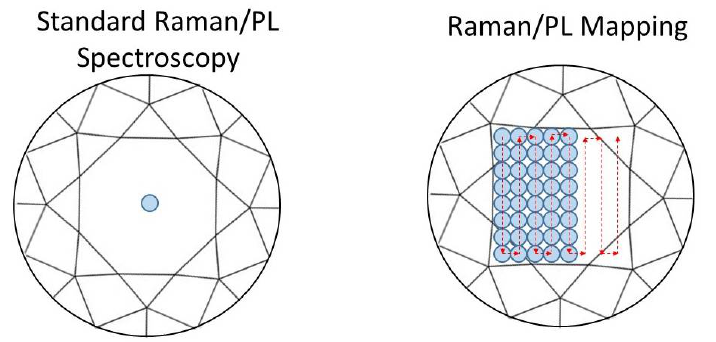
Figure 1. Data collection across the table facet of a round diamond with standard spectroscopy ( Left ) is compared against mapping spectroscopy in which spectra are collected across the entire surface ( Right ) [8].